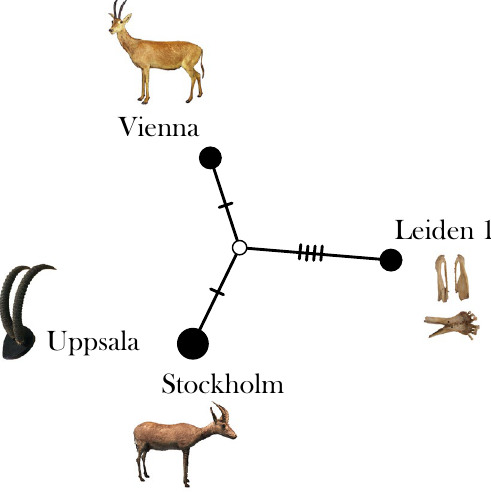
Figure 4. Median joining network of the four blue antelope specimens. The median joining network takes into account only positions of the complete mitochondrial genome (including control region) that are covered in all four specimens, excluding ambiguities (6,300 bp). Dashes and the white circle denote mutational steps and an unsampled haplotype, respectively. The network generated in POPART v1.7 57 revealed six segregating sites, with the Stockholm and Uppsala specimens being identical in this comparison. Photo credits: Leiden 1: Naturalis Biodiversity Center, the Netherlands; Stockholm: Swedish Museum of Natural History; Vienna: Natural History Museum Vienna; Uppsala: Museum of